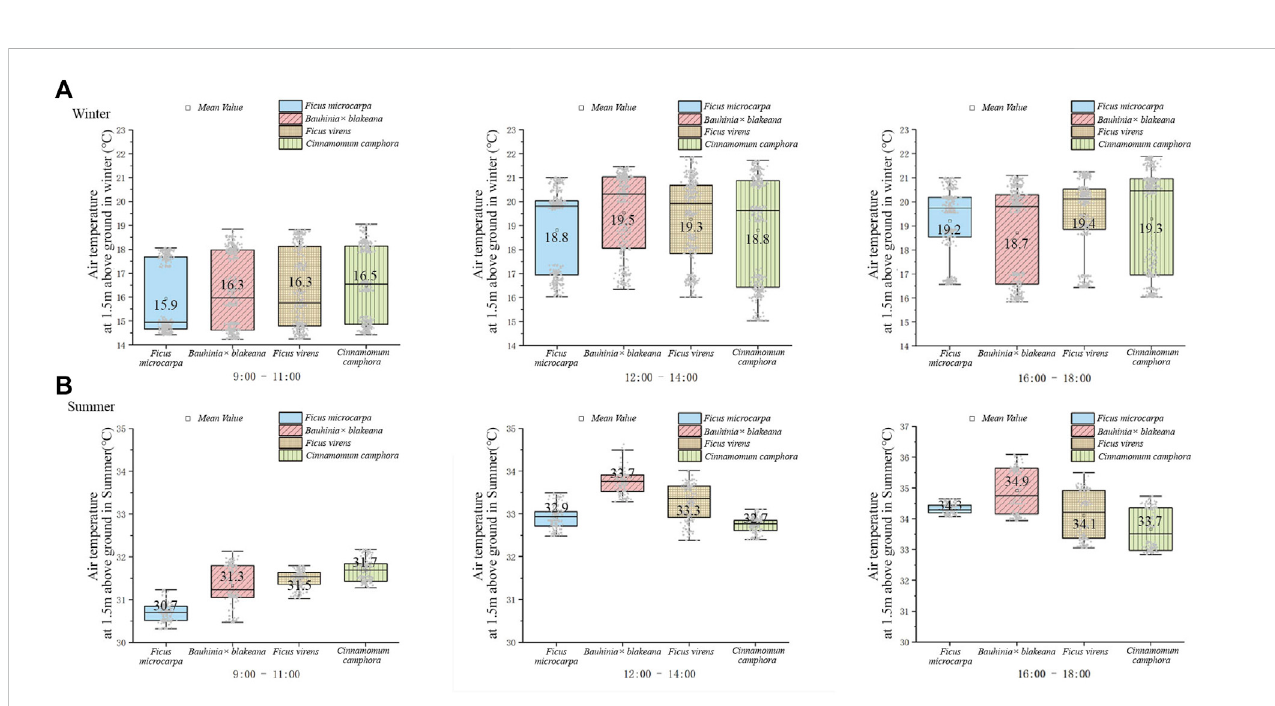
FIGURE 3 Temperatures underneath the canopy of the four tree species in winter (A) and summer (B)